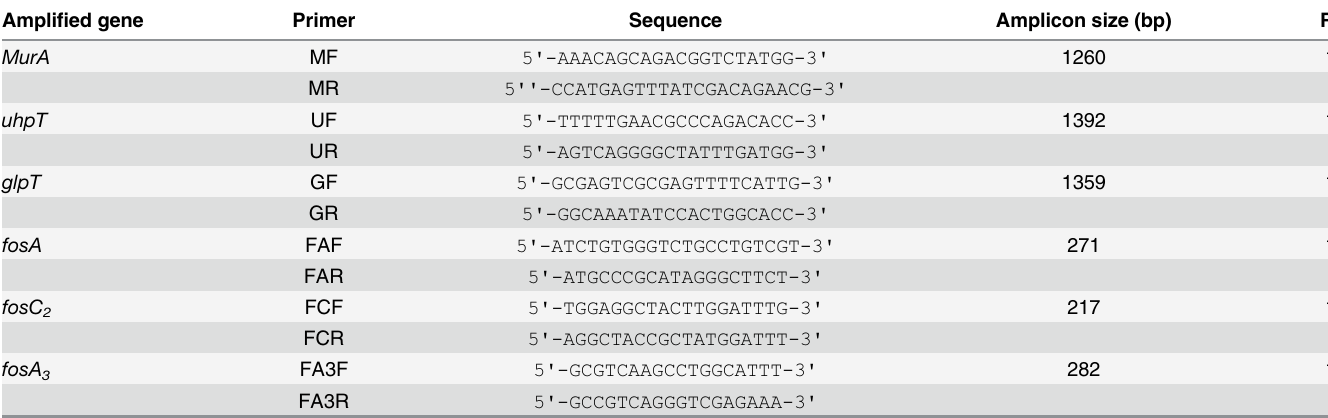
Table 1. Oligonucleotide primers